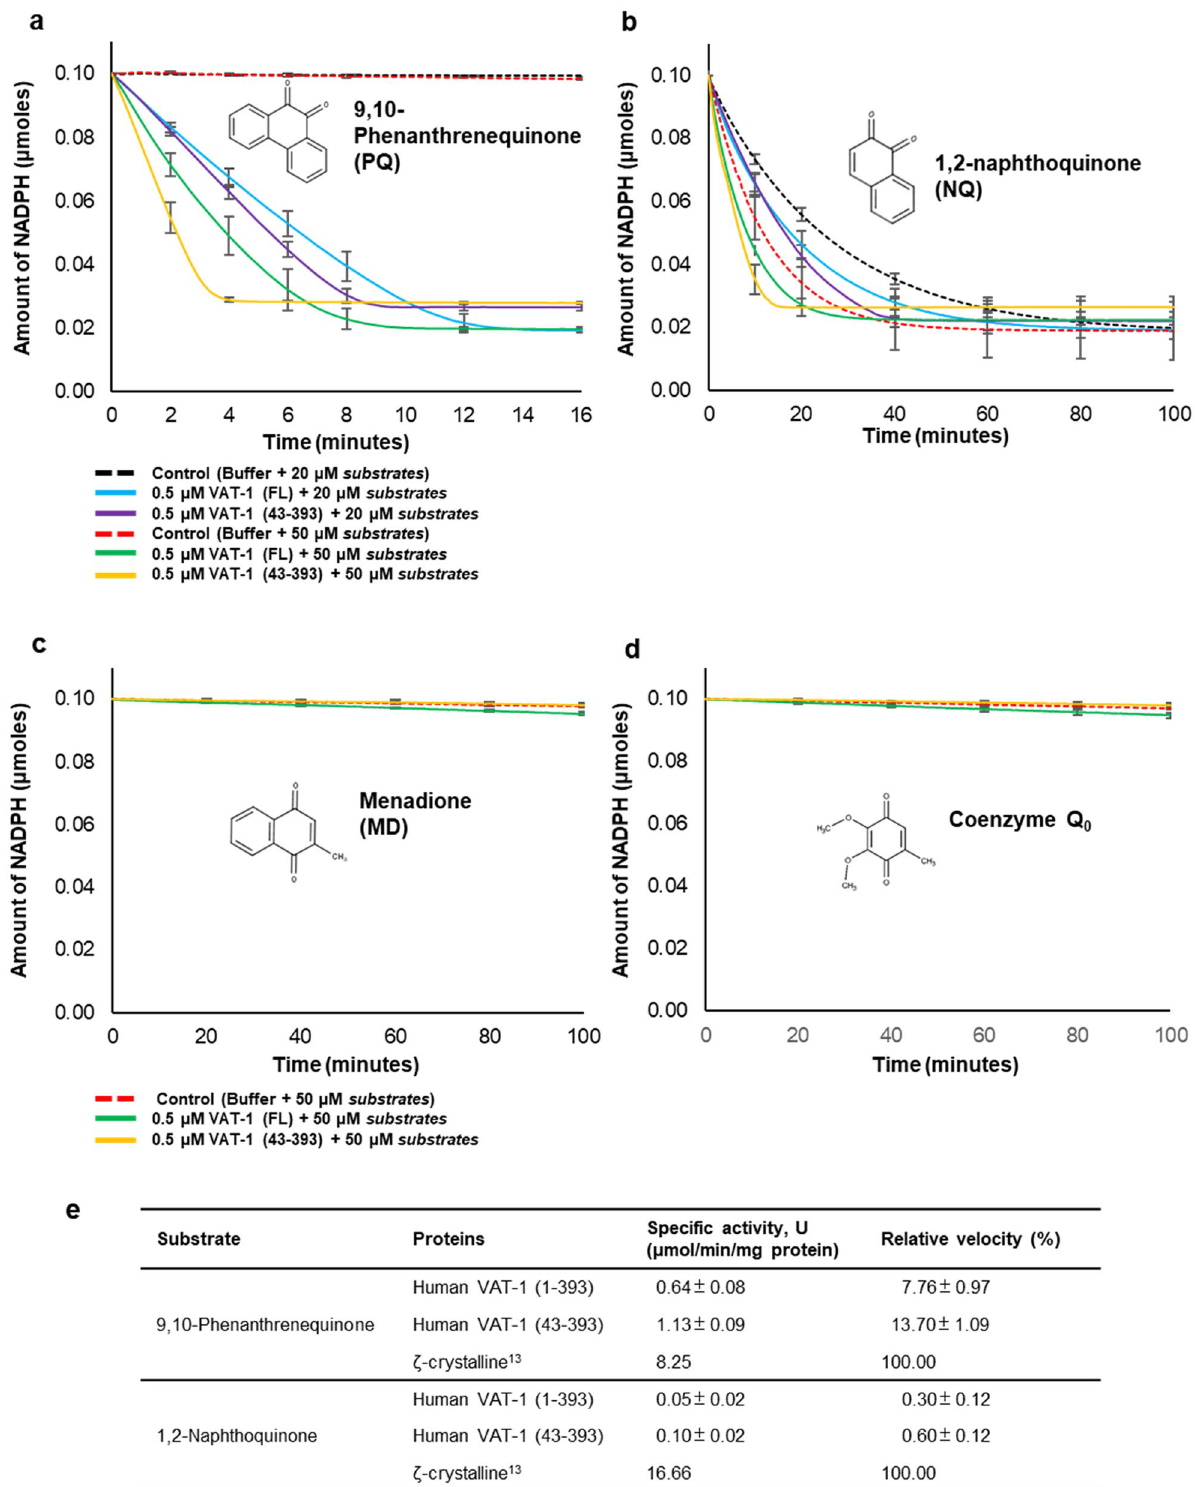
Figure 6. Potential quinone oxidoreductase activity. ( a ) Time-course of NADPH decrease in the reaction of VAT-1 (full-length) and VAT-1 (43–393) with 1,2-naphthoquinone (NQ). The chemical structure is shown in the panel. Absorbance at 340 nm was monitored to detect the decrease of the NADPH in the assay. Reactions were performed in mixtures containing 100 mM Tris–HCl (pH 7.8), 100 μM NADPH, 20 and 50 μM NQ. Control was performed without the addition of VAT-1. All the reactions were performed in triplicates, and the error bars were indicated. ( b ) As in ( a ) but for 9,10-phenanthrenequinone (PQ). ( c ) Time-course of NADPH decrease in the reaction of VAT-1 (full-length) and VAT-1 (43–393) with 50 μM menadione (MD), which is part of vitamin K3. ( d ) As in ( c ) but for ubiquinone 0 (UQ 0 ), which is part of coenzyme Q0. ( e ) Comparison of the relative activities of 0.5 μM VAT-1 (full-length)/(43–393) to that of the ζ-crystalline, using 50 μM of 1,2-naphthoquinone and 9,10-phenanthrenequinone as